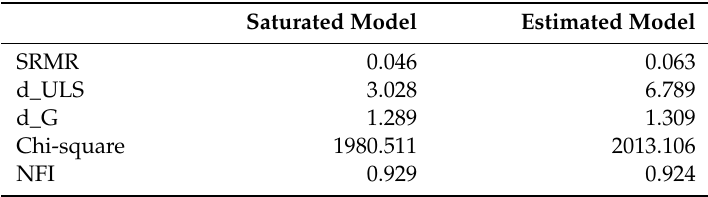
Table 7. Model fit